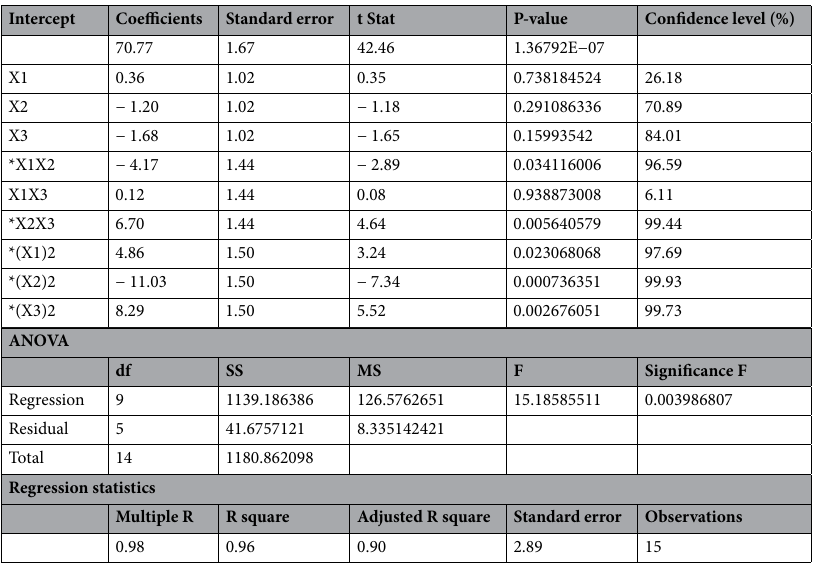
increase the quantities of dry cell mass. Since, there is a variation in dry cell mass weight from 58.18 g/l (trail 2) to 86.89 g/l (trail 13). This model is significant at a high confidence level because the F-value was several times higher than the tabulated one. The probability p -value was also very low ( p ≤ 0.05). The model coefficient of determination ( R 2 ) points out 96.47% of the response variability, which this model could designate. At the same time, 3.53% of total variation cannot be defined (Table 6). High correlation (Adj. R 2 = 0.90) also indicated the degree of accuracy that confirmed the high significance of the model. Additionally, the Pareto chart (Fig. 8A) was graphed using confidence level (%), and p -values showed the ranks of each variable; since the significant variables have confidence levels up to 95%. ANOVA determined the percent contribution of each variable and the interactions among tested variables. Figure 8B shows the highest presence contribution of different variables, which were recorded at X 2 2 (40%), followed by X 3 2 (23%), and X 1 2